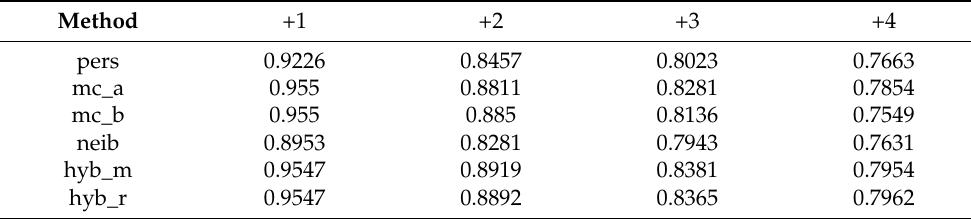
Table A2. Correlation coefficients of predicted and actual CMF time series for 4 lead time steps (+1 to +4) in 2020 for Bucharest.